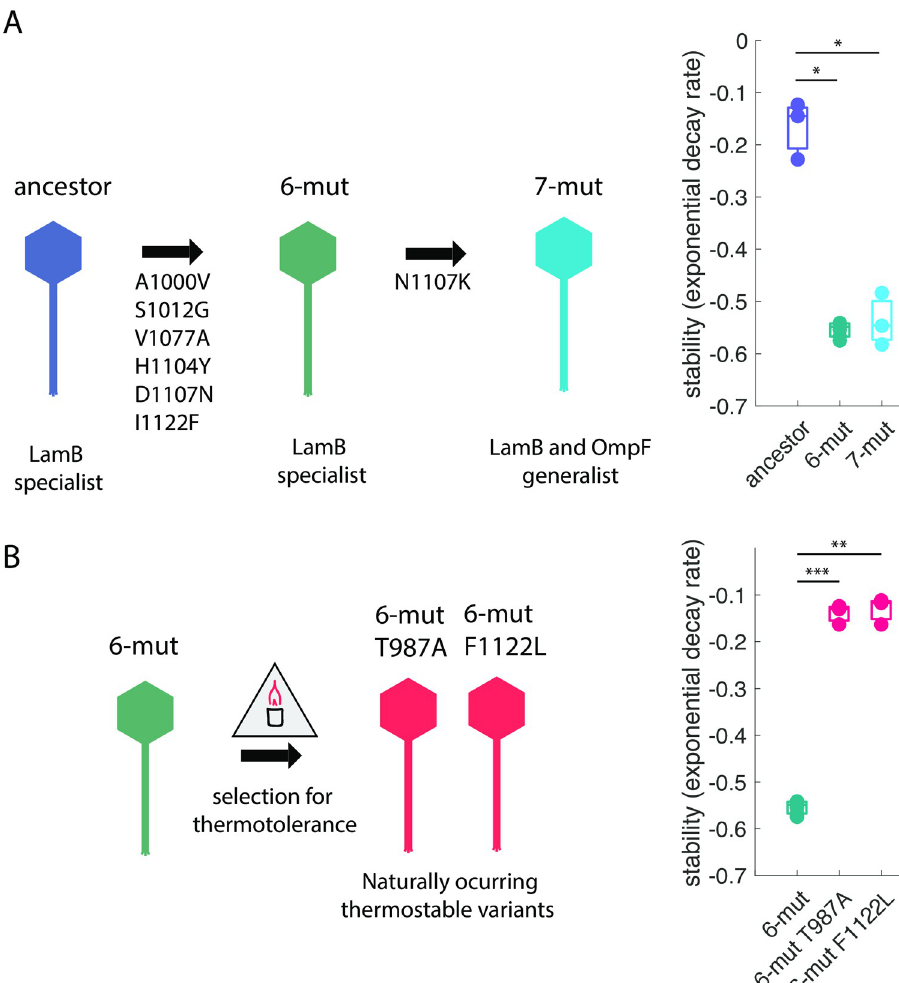
Fig 1. Experimental system and selection for thermostability. A: To generate our experimental system, we began with an unstable OmpF + genotype (7-mut) and edited out a critical mutation (N1107K), creating an OmpF — genotype that remained unstable and was on the verge of evolving OmpF + . Stability plots: n = 6 replicates for 6-mut, n = 3 replicates for ancestor, and n = 3 replicates for 7-mut. Comparisons of 6-mut and 7-mut to ancestor were made using paired t-tests corrected for multiple comparisons by Bonferroni method (ancestral λ to 6-mut: p = 8.55x10 -4 ; ancestor to 7-mut: p = 9.80 x 10 − 4 ). Bonferroni corrected significance thresholds: ns: p > 0.0024, � : p < 0.0024, �� : p < 0.00024, ��� : p < 2.4x10 -5 . B: We then selected the 6-mut for enhanced thermostability, generating two naturally evolved thermostable genotypes: T987A and F1122L. Stability plots: n = 6 replicates for 6-mut, n = 3 replicates for T987A, and n = 3 replicates for F1122L. Comparisons of 6-mut and 7-mut to ancestor were made using paired t-tests corrected for multiple comparisons by Bonferroni method (6-mut to 6-mut T987A: p = 1.40 x 10 − 5 ; 6-mut to 6-mut F1122L: p = 2.73 x 10 − 5 ). Bonferroni corrected significance thresholds: ns: p > 0.0024, � : p < 0.0024, �� : p < 0.00024, ��� : p < 2.4x10 -5